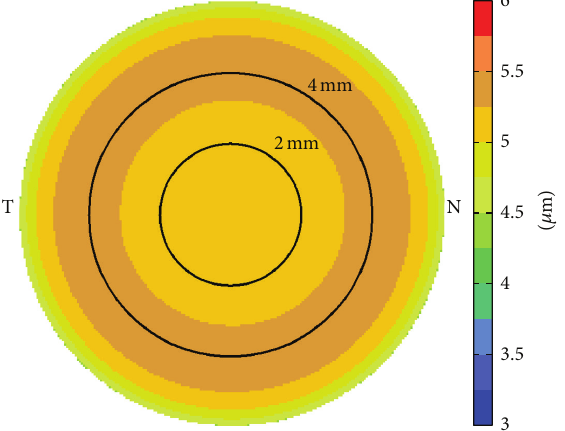
Figure 5: Simulated epithelial thickness change map after myopic LASIK of − 4.39